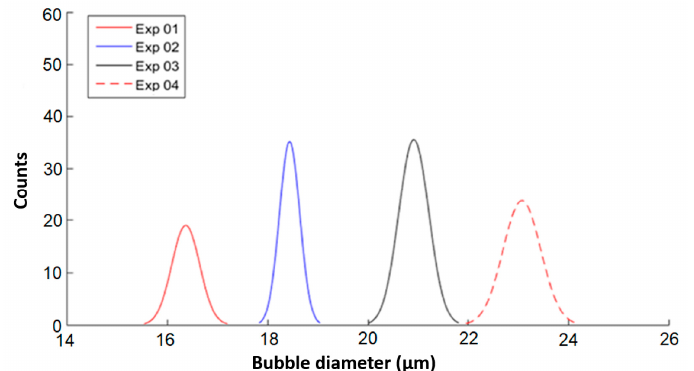
Figure 9. Gaussian distribution curve for microbubbles of different diameters due to liquid and gaseous phase flow variation.